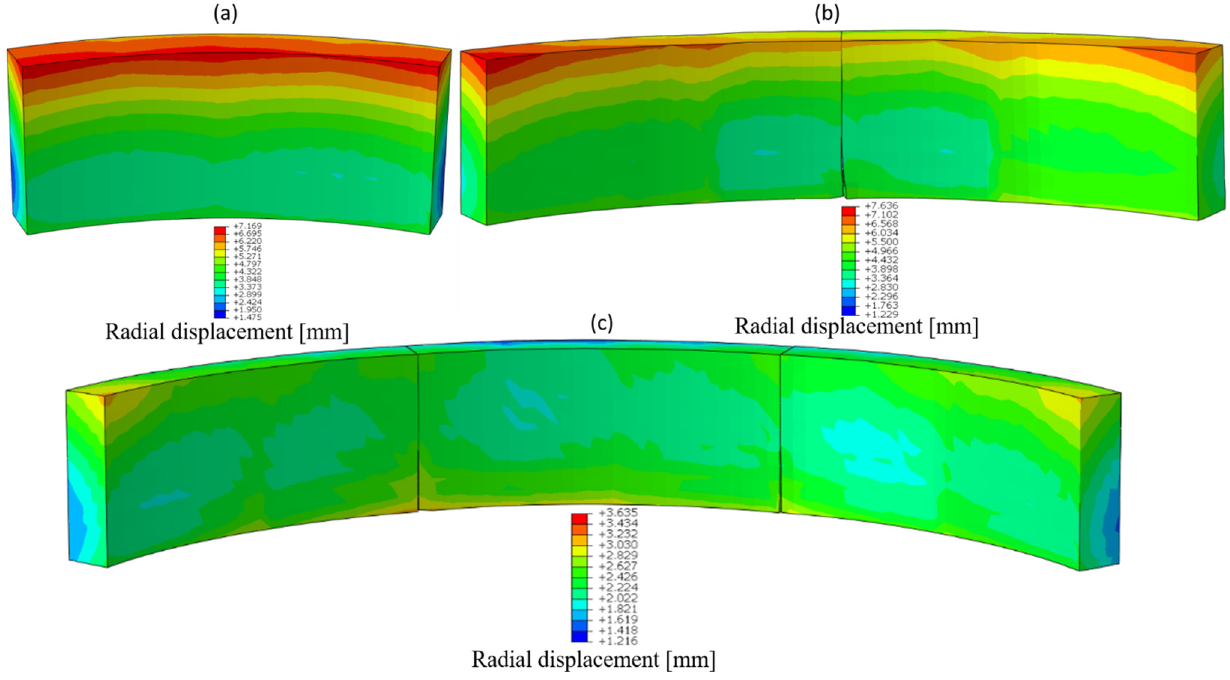
Figure 12. The interaction between the segments when the segments at the bottom: ( a ) first segment assembly; ( b ) second segment assembly; ( c ) third segment